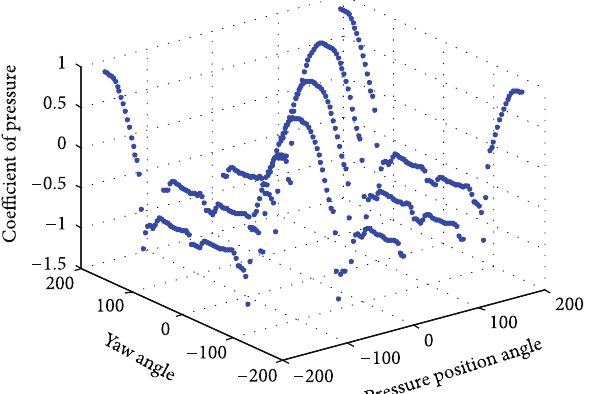
Figure 13: Fused coefficient of pressure surface as a function of yaw angle and pressure sensor